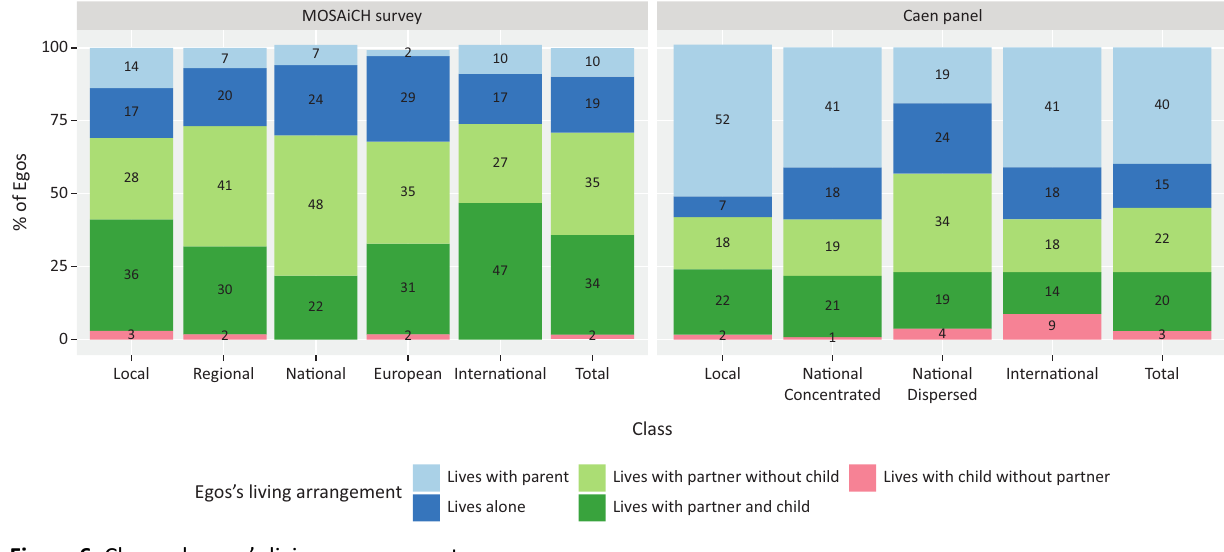
Figure 6. Classes by ego’s living